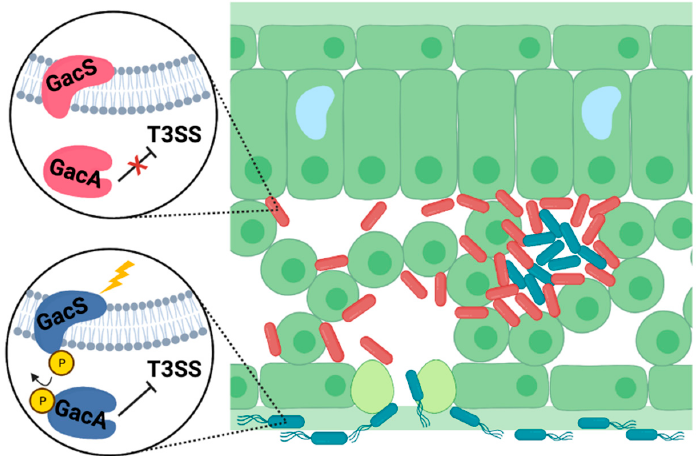
Figure 3. Hypothetical model of GacSA-mediated repression of the T3SS in P. syringae infection. Depicted is a leaf cross-section infected with P. syringae . Cells with an activated GacSA system are in blue (lower inset; GacA-P + ), while cells with an inactive GacSA system are in red (upper inset; GacA-P - ). On the leaf surface (lower leaflet), the GacSA system is activated by an unknown stimulus (lightning bolt), leading to repression of the T3SS and promotion of flagellar motility. GacA-P + cells use flagellar motility to infiltrate gaps in the leaf surface, gaining access to the leaf interior or apoplast. GacSA is deactivated within the apoplast, leading to de-repression of the T3SS. GacA-P - cells deploy the T3SS in order to disarm host immune defenses and establish P. syringae growth in the apoplast. Once P. syringae has grown to a high density within the apoplast in the advanced stages of infection, GacSA may be re-activated to downregulate T3SS expression in order to conserve cellular energy. This model of GacSA regulation is based solely on phenotypes of gacA - loss-of-function mutants and is not yet supported by biochemical evidence. Figure was made using BioRender (https://app.biorender.com, accessed on 30